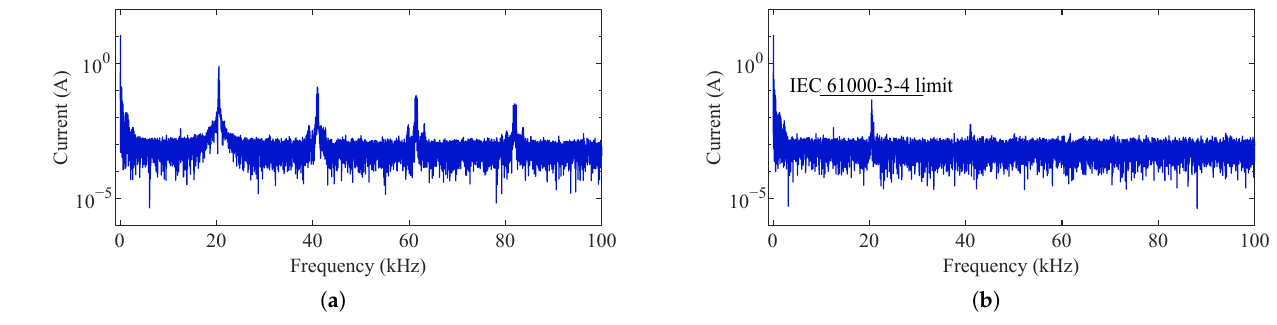
Figure 13. Frequency domain amplitudes of inductor currents. ( a ) L c . ( b ) L g